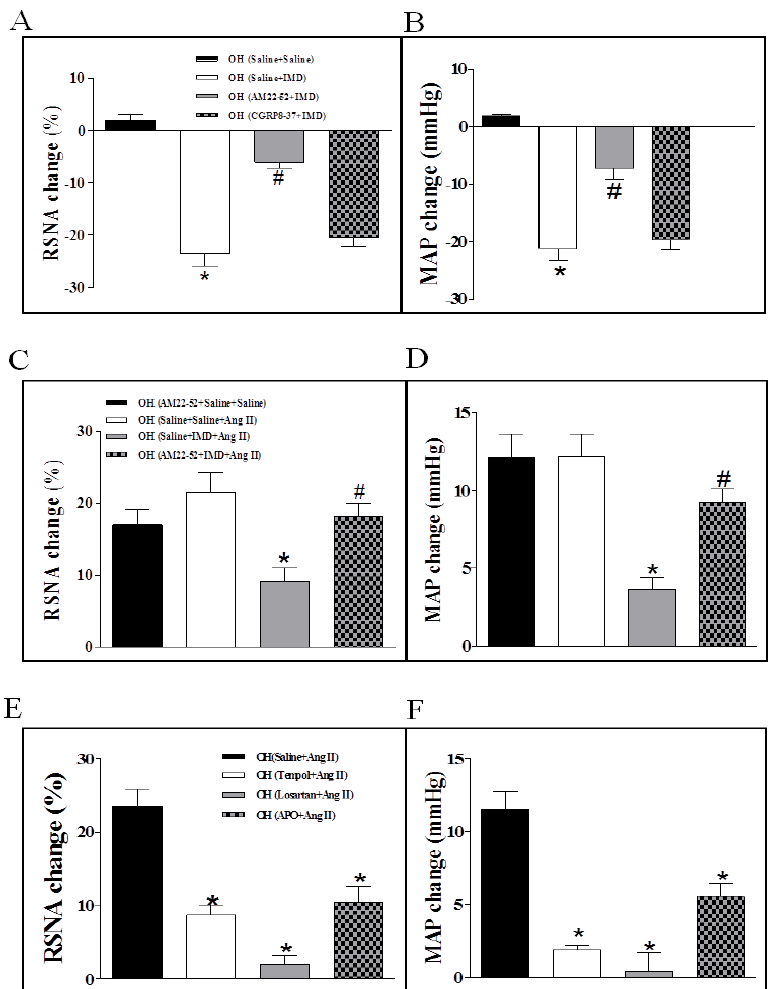
Figure 4. Effects of PVN pretreatment of AM receptor antagonist AM22-52, or CGRP antagonist CGRP8-37 on RSNA and MAP responses to IMD (50 pM) in the PVN of OH rats ( A , B ); effects of AM22-52 pretreatment on IMD (50 pM) responses to Ang II (0.3 nM)-induced sympathetic activation in the PVN of OH rats ( C , D ); and PVN pretreatment with superoxide scavenger Tempol, AT1R antagonist Lorsatan and NADPH oxidase inhibitor Apo on RSNA and MAP responses to Ang II (0.3 nM) in the PVN of OH rats ( E , F ). Values are mean ± SEM. * p < 0.05 versus saline + saline; # p < 0.05 versus saline + IMD ( A , B ). * p < 0.05 versus saline + saline + AM22-52 or saline + saline + Ang II; # p < 0.05 versus saline + IMD + Ang II ( C , D ). * p < 0.05 versus saline + Ang II ( E , F ). n = 6 for each group.